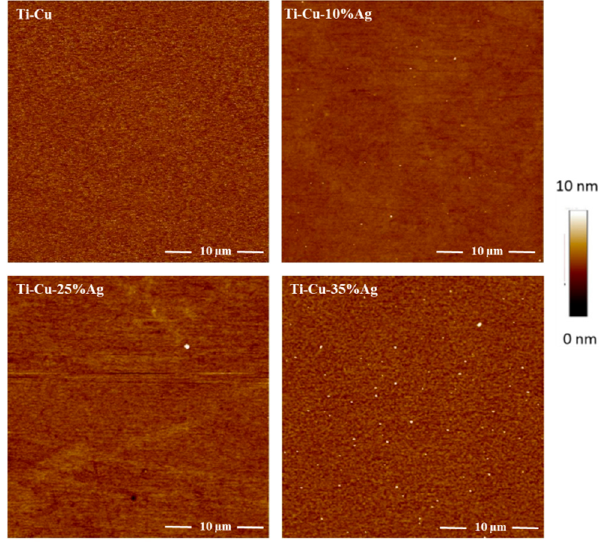
Figure 4. Atomic force microscope (AFM) images of the Ti-Cu and Ti-Cu-Ag thin films with 10, 25, and 35 at.% of Ag.